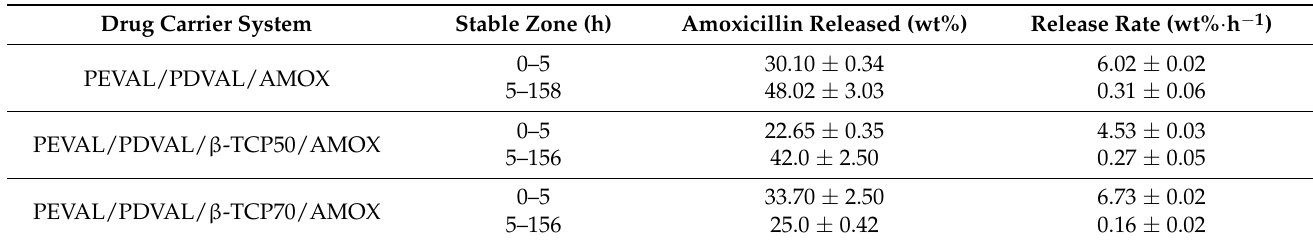
Figure 11. Cumulative amoxicillin released from the PEVAL/PDVAL/ β -TCP/AMOX drug carrier systems. Table 2. Stable zones and instantaneous release of amoxicillin from PEVAL/PDVAL/AMOX and PEVAL/PDVAL/ β - TCP/AMOX drug carrier systems with different β -TCP